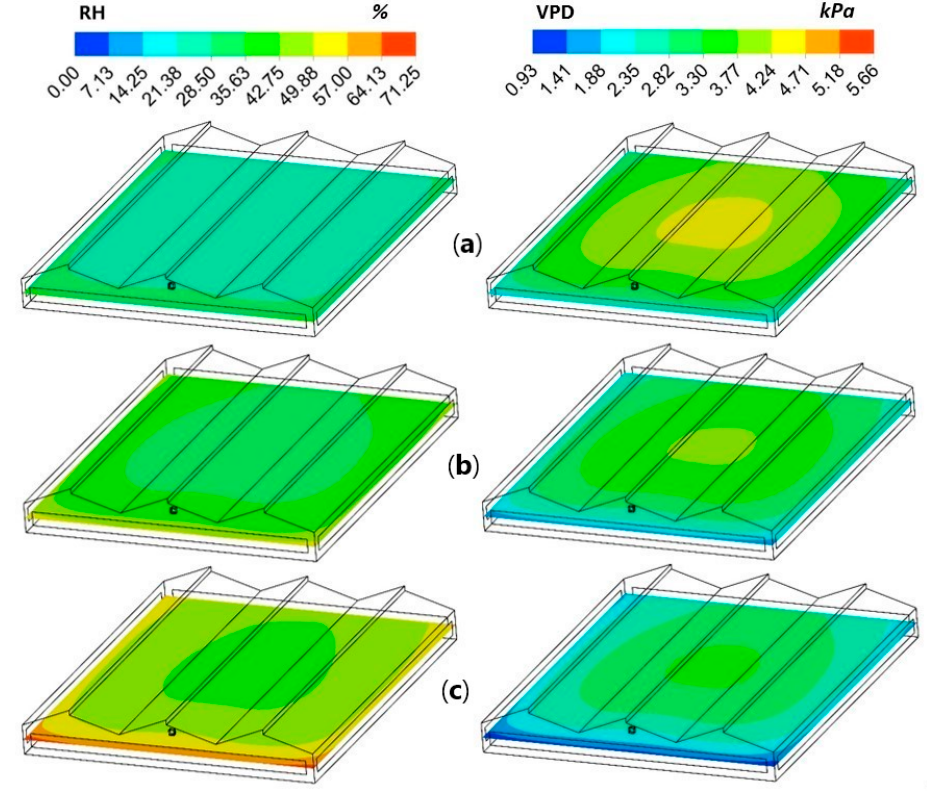
Figure 4. Distribution of RH (%) and VPD (kPa) in the greenhouse at 1.5 m height in the simulations for the three scenarios ( a – c ) specified in Table 6.